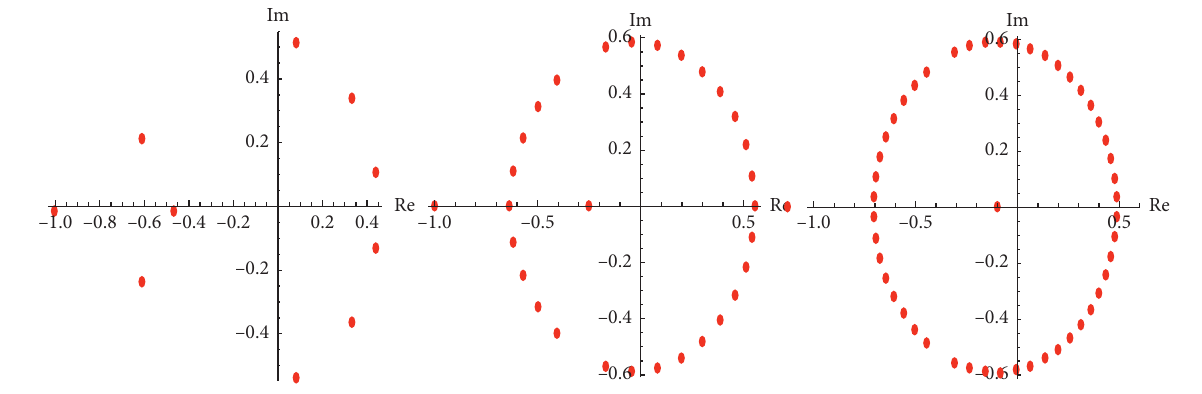
Figure 2: Zeros of S Table 1: Approximate zeros of S